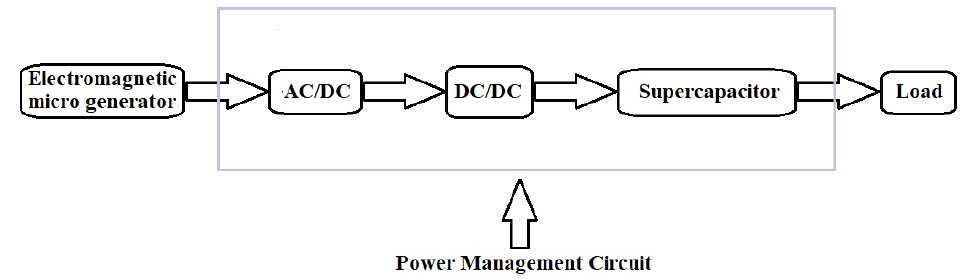
Figure 2. Harvester system architecture.